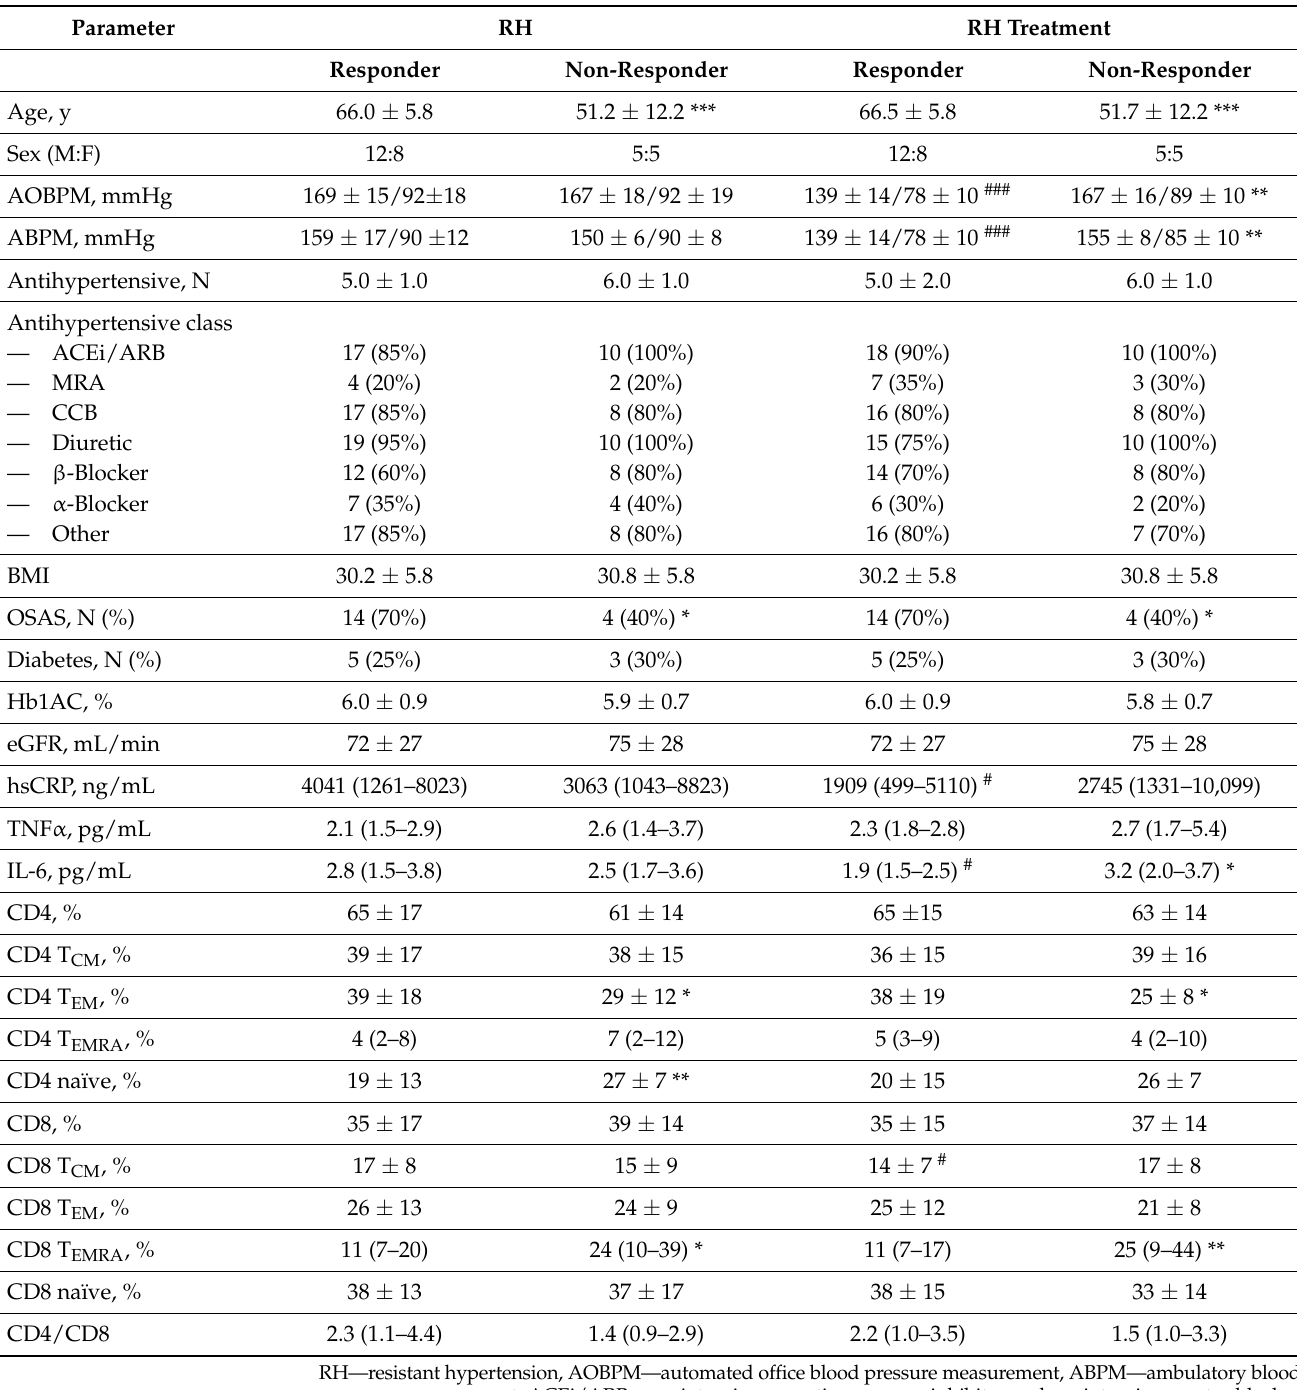
Table 1. Characteristics of responders and non-responders before and after the renal denervation